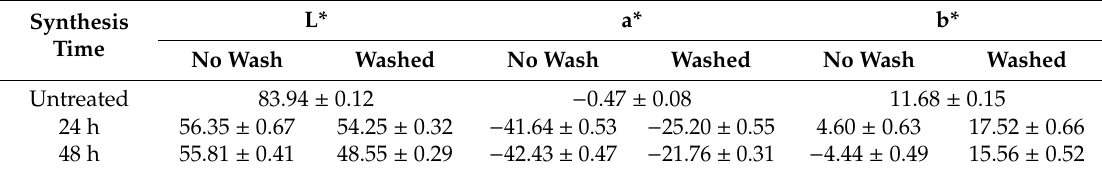
Table 2. Color data for the wool fabric modified with HKUST-1 after 24 and 48 h of direct synthesis.